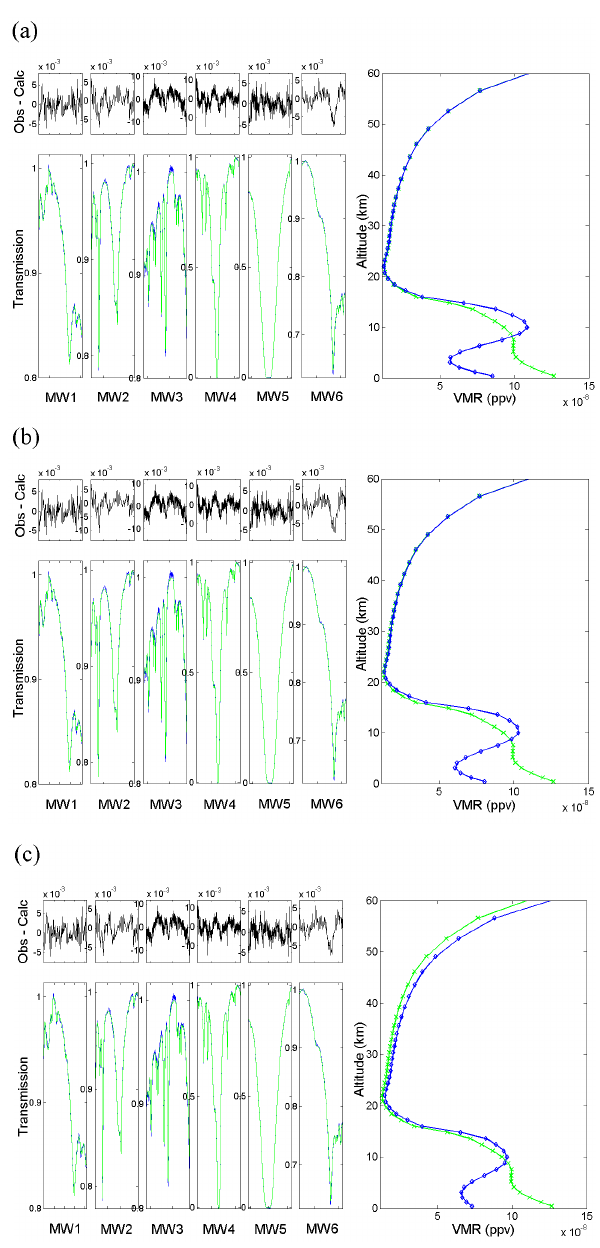
Fig. 9. Multiple micro-window (MW1: MW6: 2168.84–2169.02 cm − 1 ) fit of CO plus interfering species from a single spectrum on 29 July 2007 at St.-Denis using the (a) OEM, (b) IOA and (c) TR. Measured (blue) and simulated (green) spectra are shown (left lower plot), together with the residuals (left upper plot), computed as measured minus simulated. The right plot shows the a priori (green crosses) and retrieved (blue diamonds)